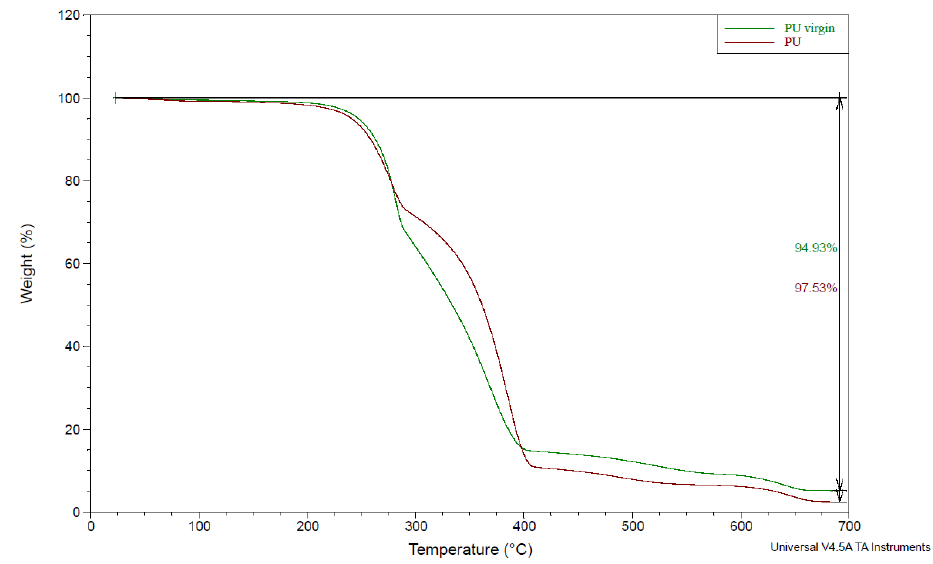
Figure 2. The Thermogravimetric analysis (TGA) of the PU foam (PU) and original PU foam (PU- virgin) at the end of the experiment (17 days).